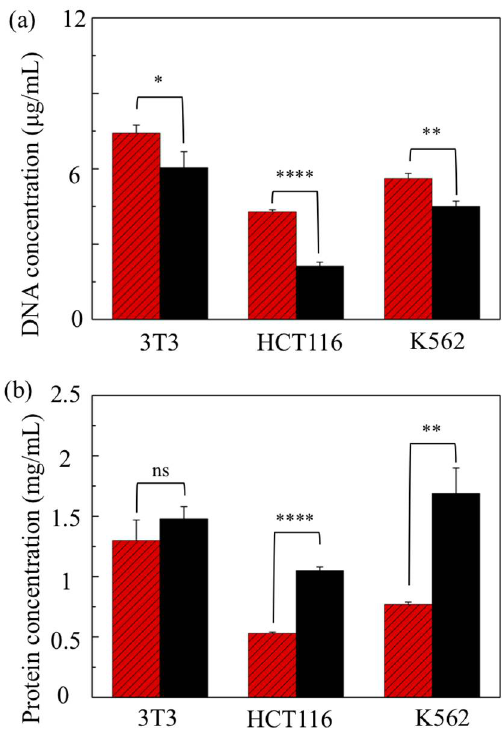
Figure 4. ( a ) DNA and ( b ) protein levels in the lysates of three distinct cell lines obtained through an eight-constriction treatment (light-shaded columns) and a chemical treatment (dark-shaded columns). The constrictions are w = 10 µ m and d = 7 µ m. The population density is 2.5 × 10 6 cells / mL. (ns: not significant; ∗ p < 0.05; ∗ ∗ p < 0.01; ∗ ∗ ∗ ∗ p < 0.0001; two-tailed t -test). Error bars: ± 1 SD ( n = 3 ).